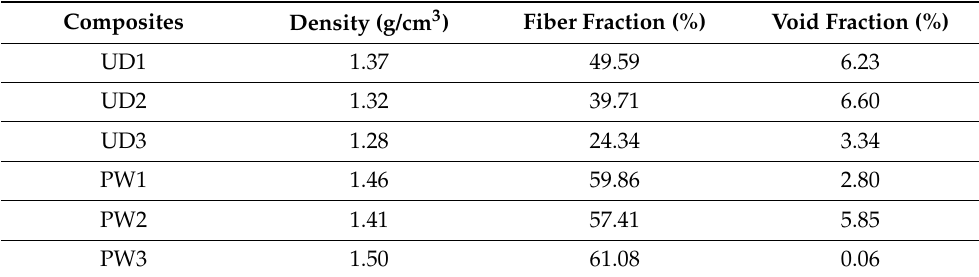
Table 1. Properties of VB-molded PT30/carbon fiber composites.